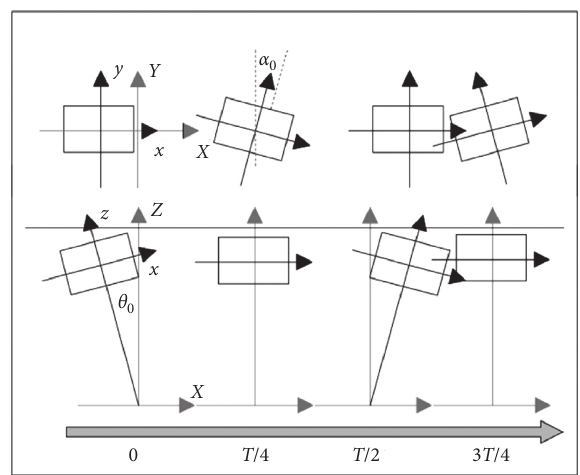
Figure 1: Inertial and noninertial Cartesian reference frames used to describe the reactor swing and the dynamics of ball and powder particles inside the